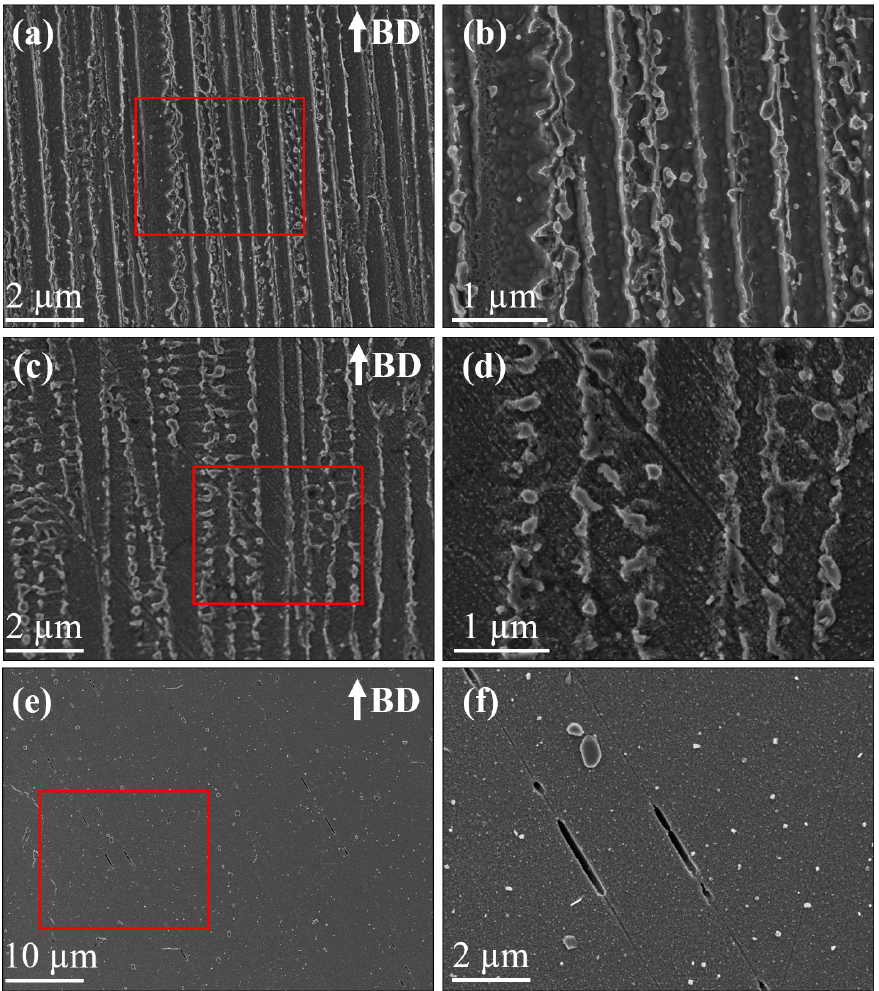
Figure 12. SEM images of the microstructure post-deformation. ( a , b ) AB condition having no planar slip bands and un-sheared Laves phase particles. ( c , d ) DA condition showing planar slip bands and some sheared Laves phase particles. ( e , f ) HSA condition showing planar shear